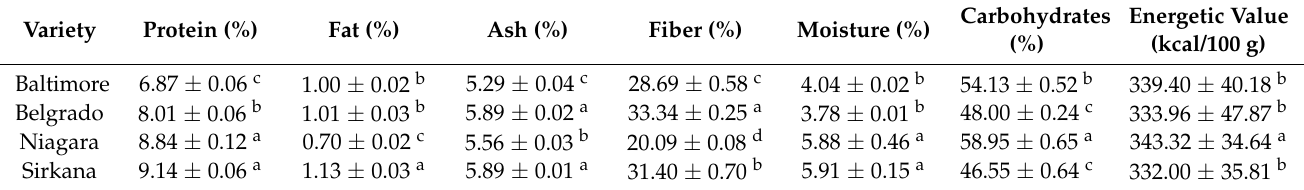
Table 1. Chemical composition of carrot pomace